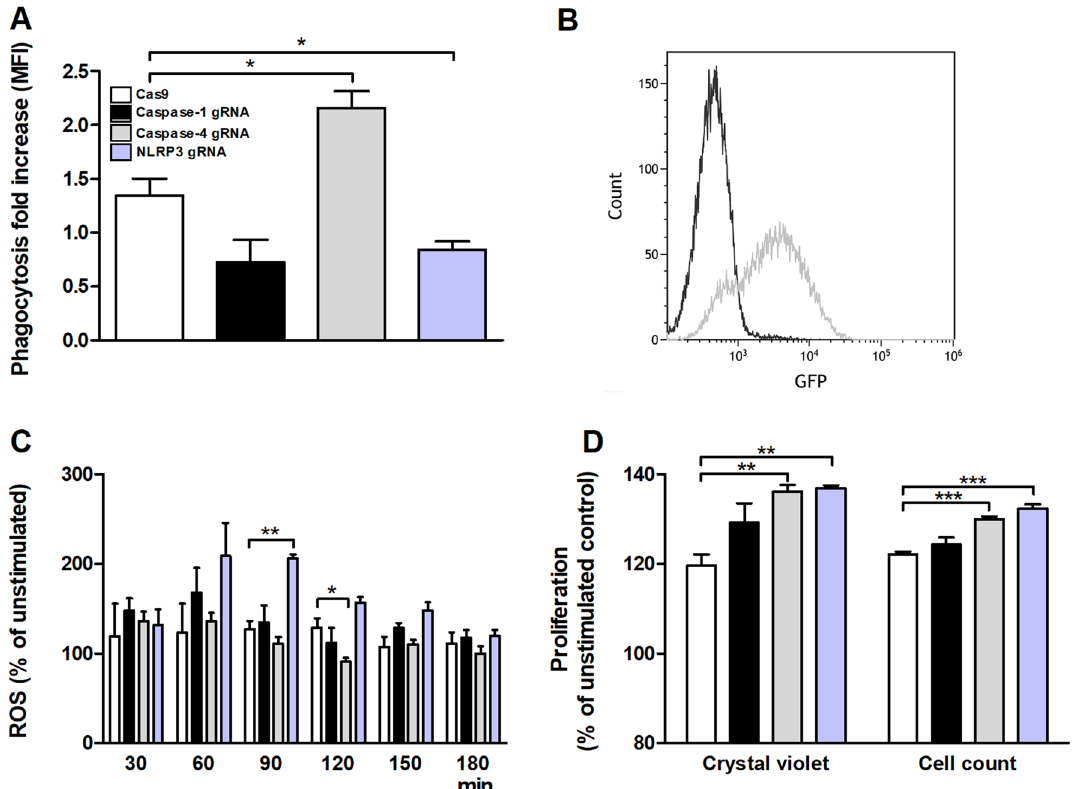
Figure 6. Bacterial phagocytosis, production of reactive oxygen species (ROS) and bladder epithelial cell proliferation. Neutrophils were exposed to conditioned medium from Cas9 controls, caspase-1, caspase-4 and NLRP3-knockdown bladder epithelial cells and phagocytosis of CFT073 (eGFP) (3 h, A , B ) and ROS- production was evaluated ( C ). Conditioned medium from respective knockdown cell lines was added to wild- type epithelial cells and proliferation was then evaluated after 24 h ( D ). Phagocytosis is expressed as fold change (mean florescence intensity) relative to the unstimulated control. A representative flow cytometry histogram illustrating neutrophils with (grey) or without (black) phagocytosis of CFT073 is shown in B. ROS production is presented as % of unstimulated control. gRNA stands for guideRNA targeting specific gene using CRISPR/Cas9. Data are presented as mean ± SEM of three independent experiments. (* p < 0.05, ** p < 0.01, *** p <